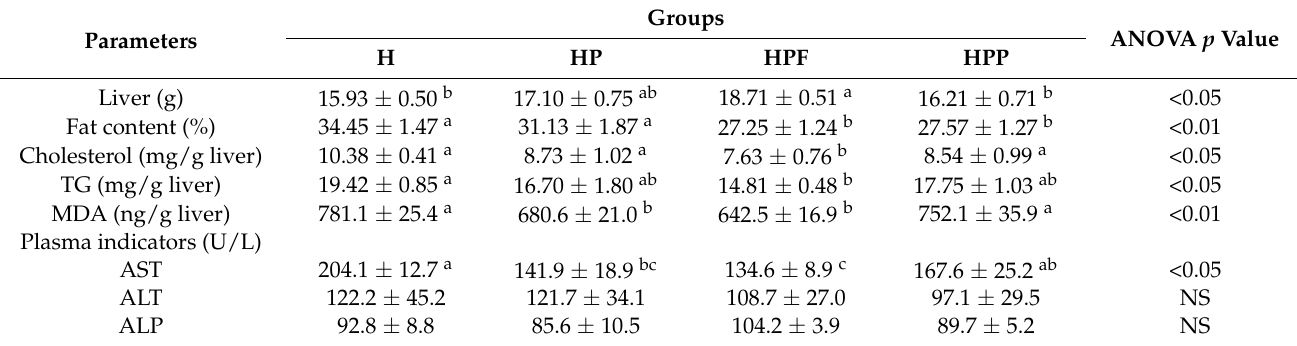
Values are the mean ± SEM; n = 8. AST, aspartate transaminase; ALT, alanine transaminase; ALP, alkaline phosphatase; MDA, malondialdehyde; TG, triglyceride. a,b,c Mean values not sharing the same superscript letter within a row (a, b or c) are different at p < 0.05 in a post hoc test. (Dunn’s test). H, control high-fat diet; HP, control high-fat diet enriched with raspberry polyphenol extract; HPF, control high-fat diet enriched with raspberry polyphenol extract and fructo-oligosaccharides; HPP, control high-fat diet enriched with raspberry polyphenol extract and pectin.